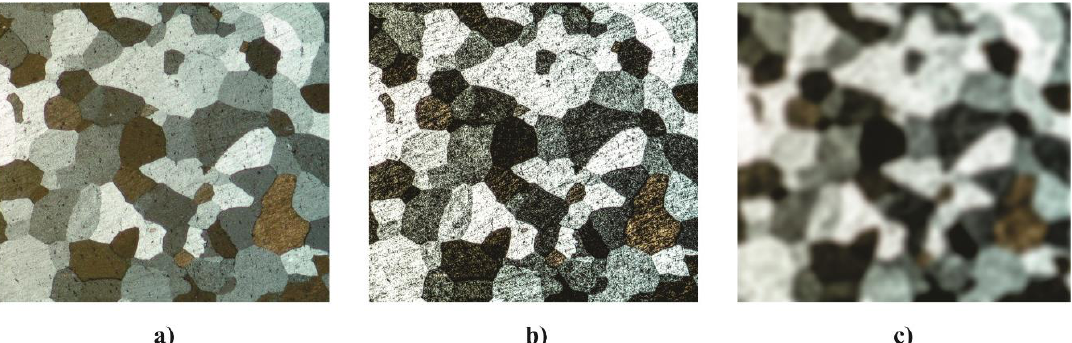
Figure 4. The original microstructure image ( a ) contrast manipulation ( b ) with an enhancement of the picture details, while preserving edges based on a local Laplacian filter with 𝛼 = 0.1 , 𝜎 𝐿 = 0.5 and 𝛽 = 0 . Gaussian filtering ( c ) to blur the image with 2D 47 × 47 convolution kernel and standard deviation 𝜎 𝐺 = 8 .